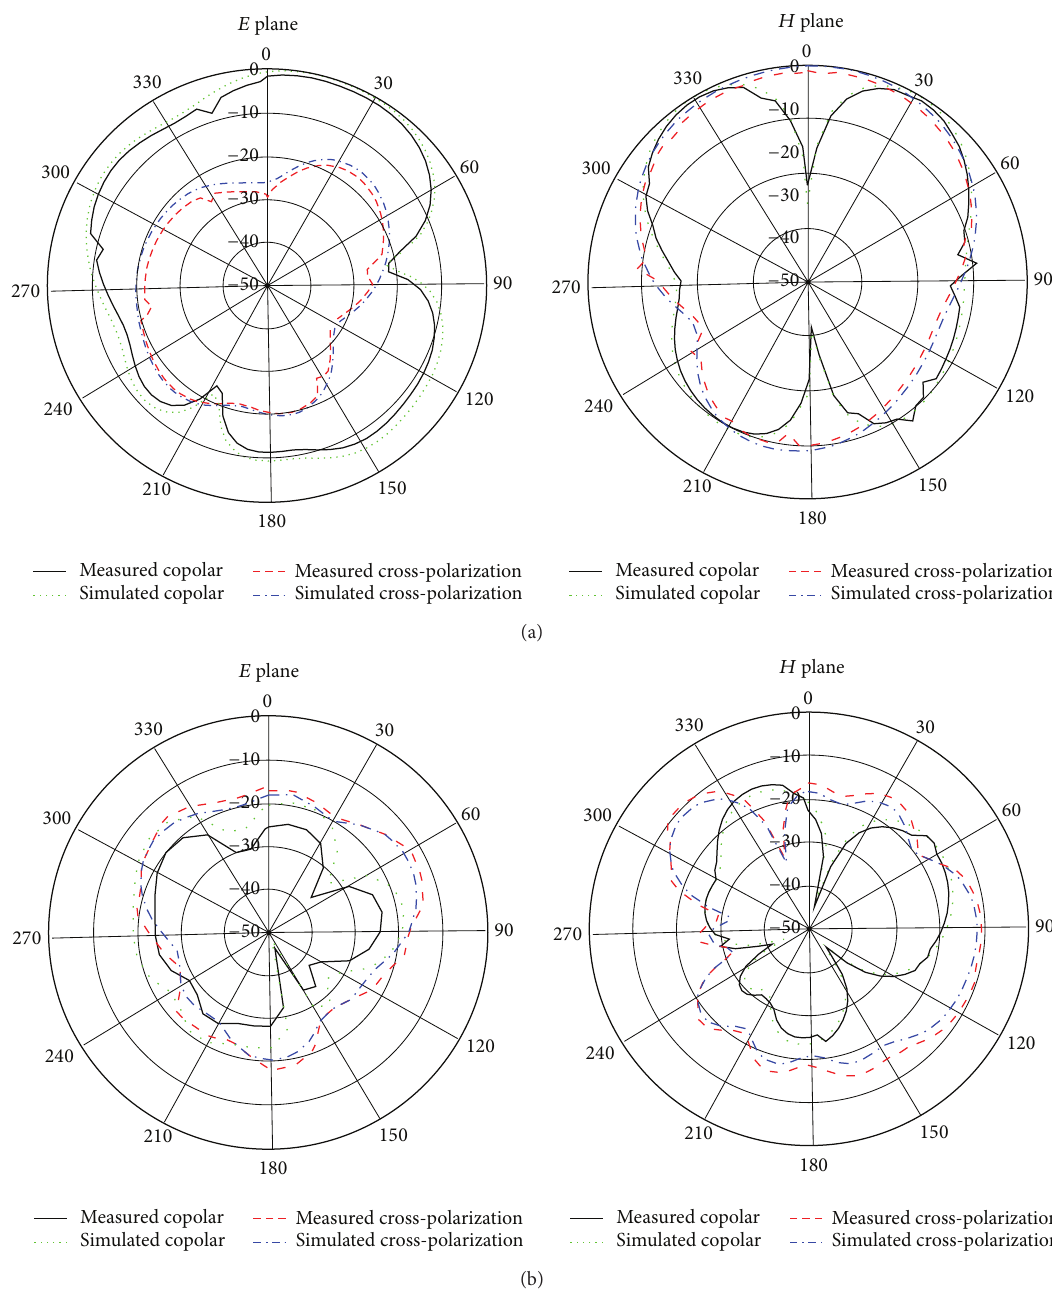
Figure 17: 𝐸 - and 𝐻 -plane radiation patterns of the proposed antenna at (a) 8.25 GHz and (b) 9.95